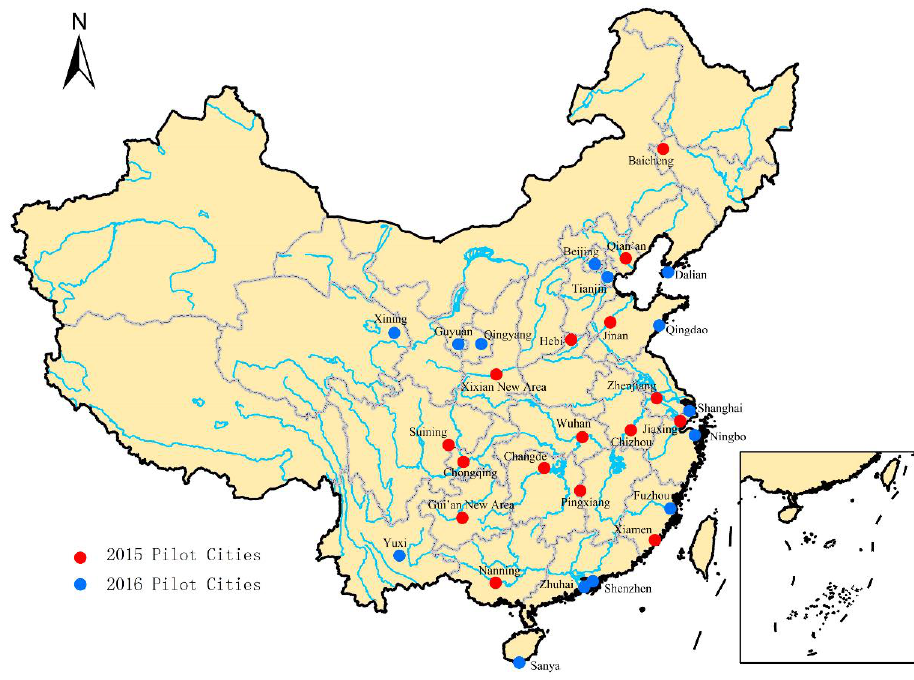
Figure 8. Location of Sponge City pilots in China (Source: Li et al. (2017)) [132].